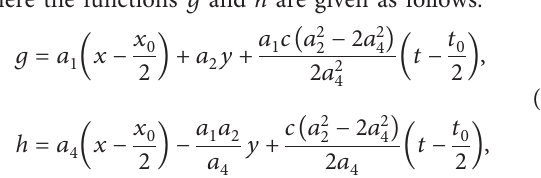
Figure 7: The density plot of the symmetry breaking lumps of the AB-KP systems (7a) and (7b), with the selected parameters b � b � 0 and (b) and (c) b (a) b 1 2